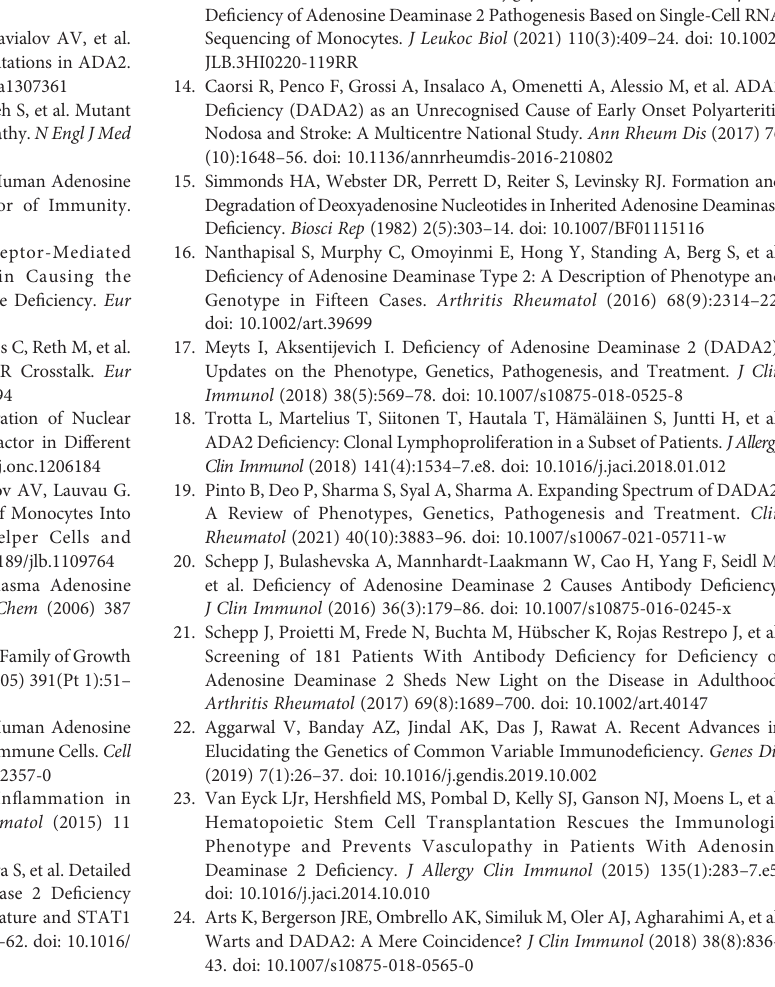
Supplementary Table 1 | Variants in DADA2 gene. Supplementary Figure 1 | DADA2 gene sketch showing disease associated mutations in ADA2